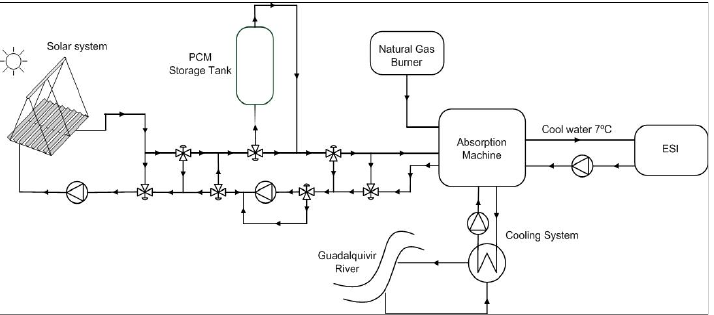
Figure 1. Plant general scheme.